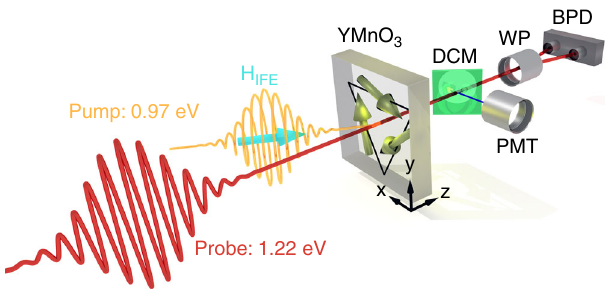
Fig. 1 Illustration of the two-colour pump – probe setup. A circularly polarised 130 fs laser pulse at 0.97 eV induces a spin canting in YMnO 3 via the IFE. The subsequent spin precession is probed with a linearly polarised 1.22 eV laser pulse via a simultaneous measurement of the Faraday rotation (using a Wollaston prism (WP) and a balanced photodiode (BPD)) and the SHG signal (using a Glan – Taylor prism and a photomultiplier tube (PMT), to which the frequency doubled light was branched off by a